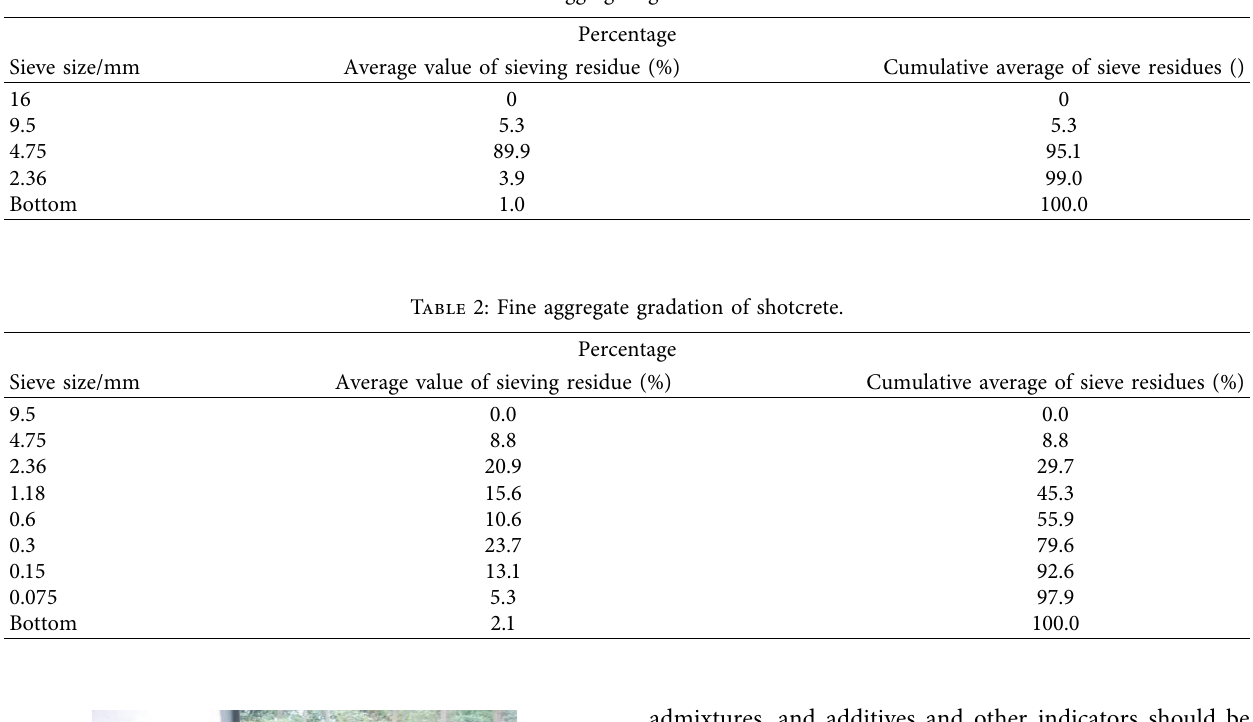
Table 1: Coarse aggregate gradation of shotcrete.